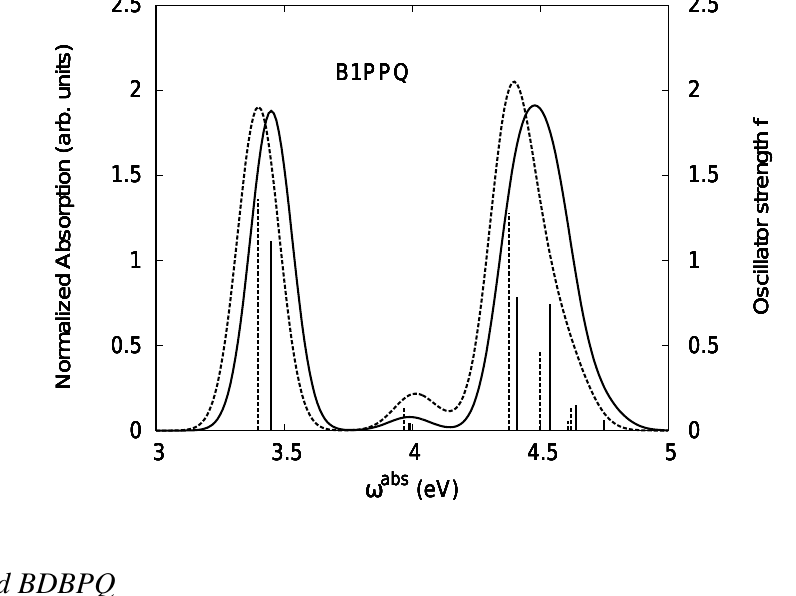
Figure 2. Normalized absorption I of Equation (13) (in arbitrary units) (right side) and oscillator strength f (left side) of B1PPQ. The solid and dashed curves represent the normalized absorption in gas phase and solution, while the solid and dashed “sticks” represent the oscillator strength in gas phase and solution,